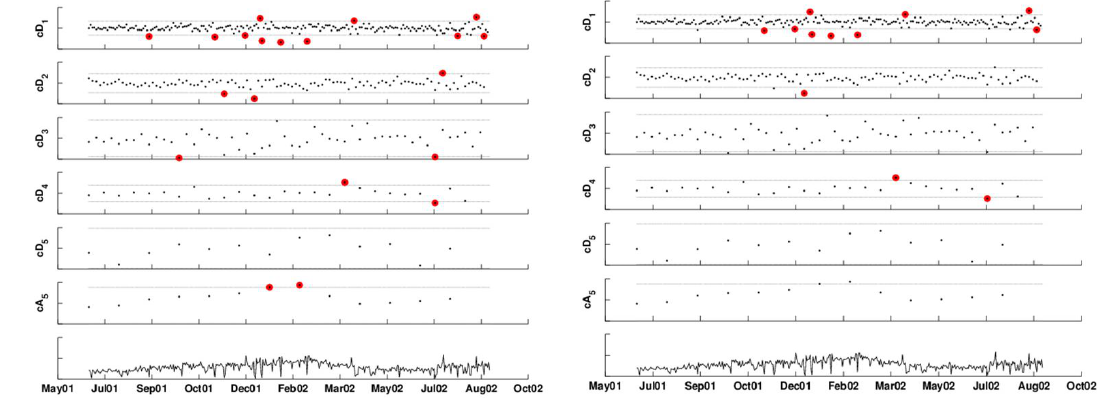
Figure 12. DWT of the time-series with 3-sigma x-bar charts applied at each scale. The left panel shows alarms based on coefficients that exceed the thresholds. The right panel shows alarms after correcting for multiple testing.